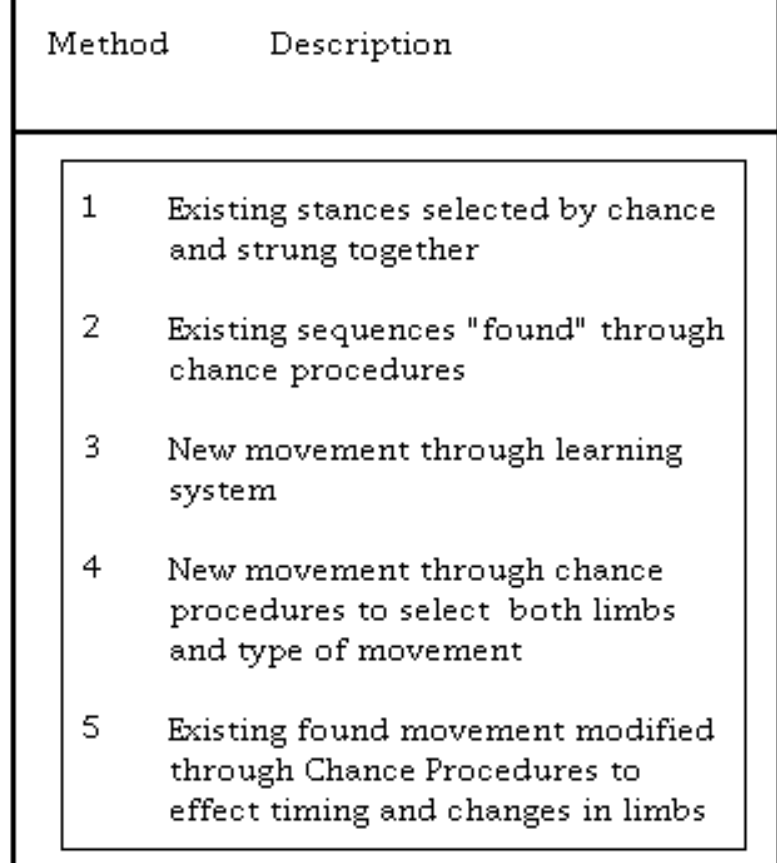
Figure 4.7. Methods of LifeForms Sequence